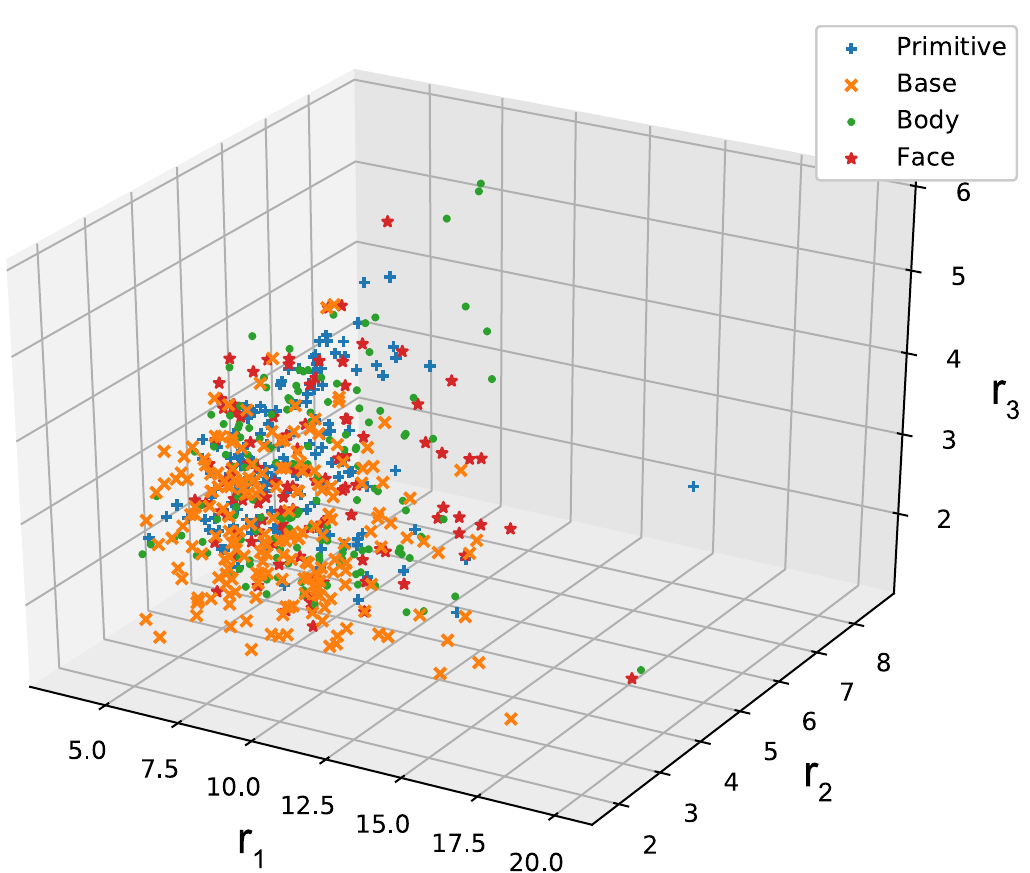
Fig 7. Estimated radii of ellipsoids. Each plot at ( r 1 , r 2 , and r 3 ) indicates the radii of ellipsoids packed in a crystal that was identified in Table 1. The blue pluses, orange crosses, green circles, and red stars correspond to type-P, type-C, type-I, and type- R,